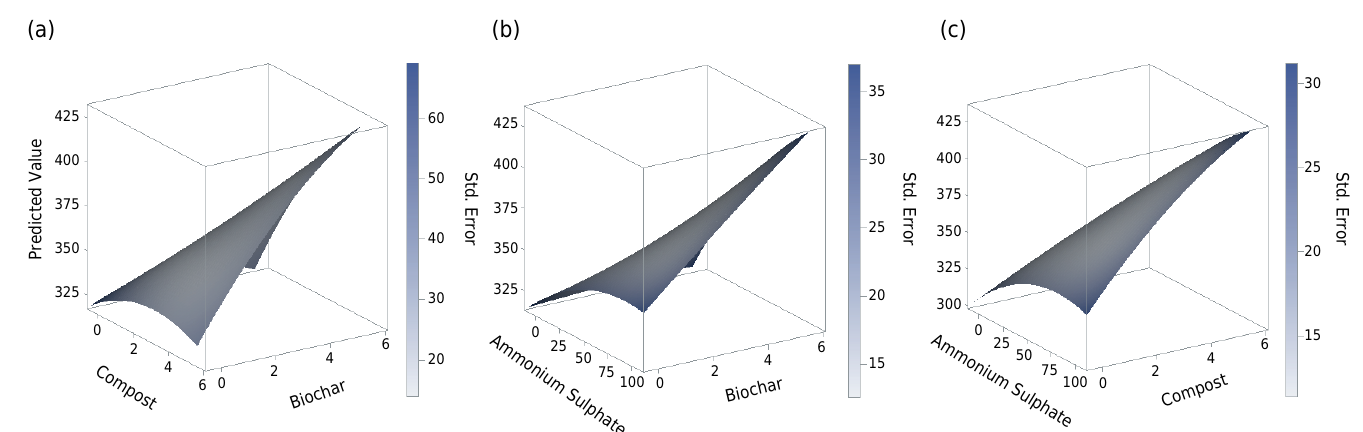
Figure 4. The LPR (μmol m -2 s -1 CO 2 ) response to independent variable: (a) biochar (t ha -1 ) and compost (t ha -1 ); (b) biochar (t ha -1 ) and ammonium sulphate (kg ha -1 ); (c) compost (t ha -1 ) and ammonium sulphate (kg ha -1 ).